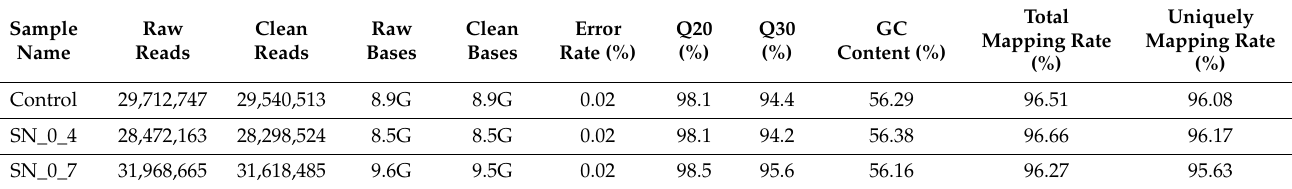
Table 1. Summary of RNA-seq